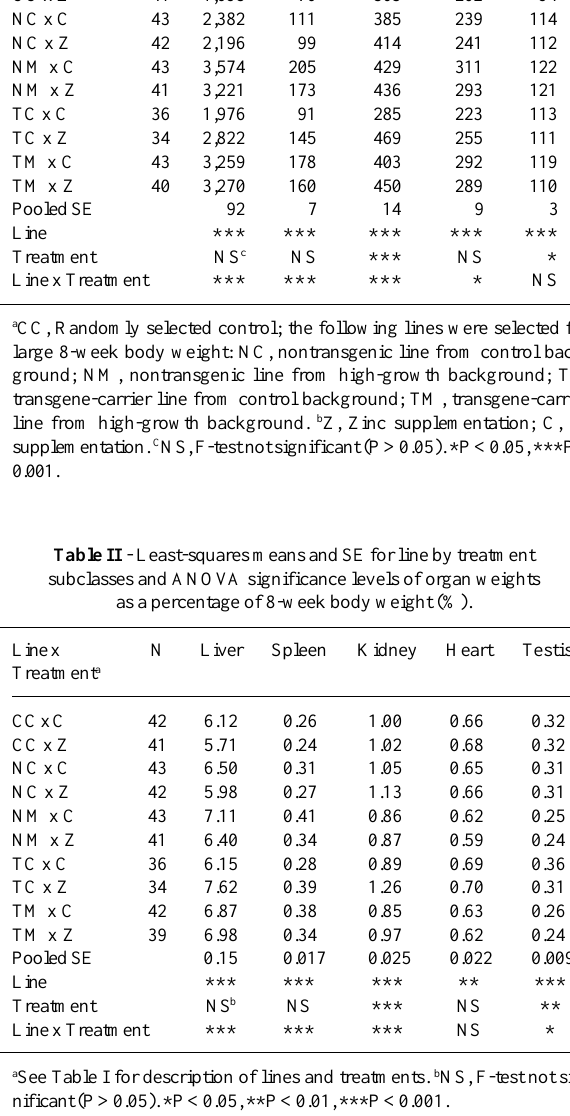
a See Table I for description of lines and treatments. b NS, F-test not sig- nificant (P > 0.05). *P < 0.05, **P < 0.01, ***P < 0.001.